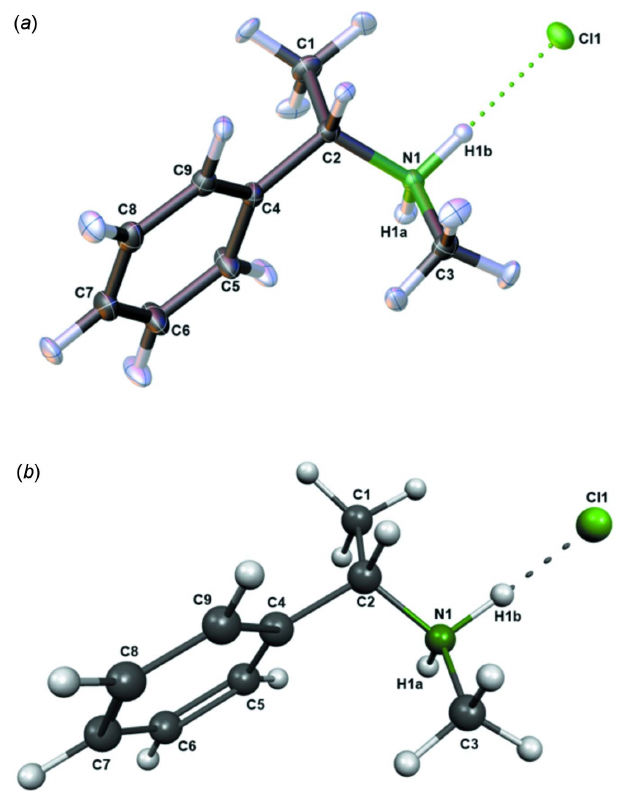
Figure 1 (a) The molecular structure of 1 illustrated showing 50% displacement ellipsoids including. All hydrogen atoms except H1 b were refined by Hirshfeld atom refinement (HAR) performed by NoSpherA2 implemen- tation in OLEX2. ( b ) Visualization of the calculated structure of compound 1 with Molekel 4.3 performed at the M062X/6–31+G( d )